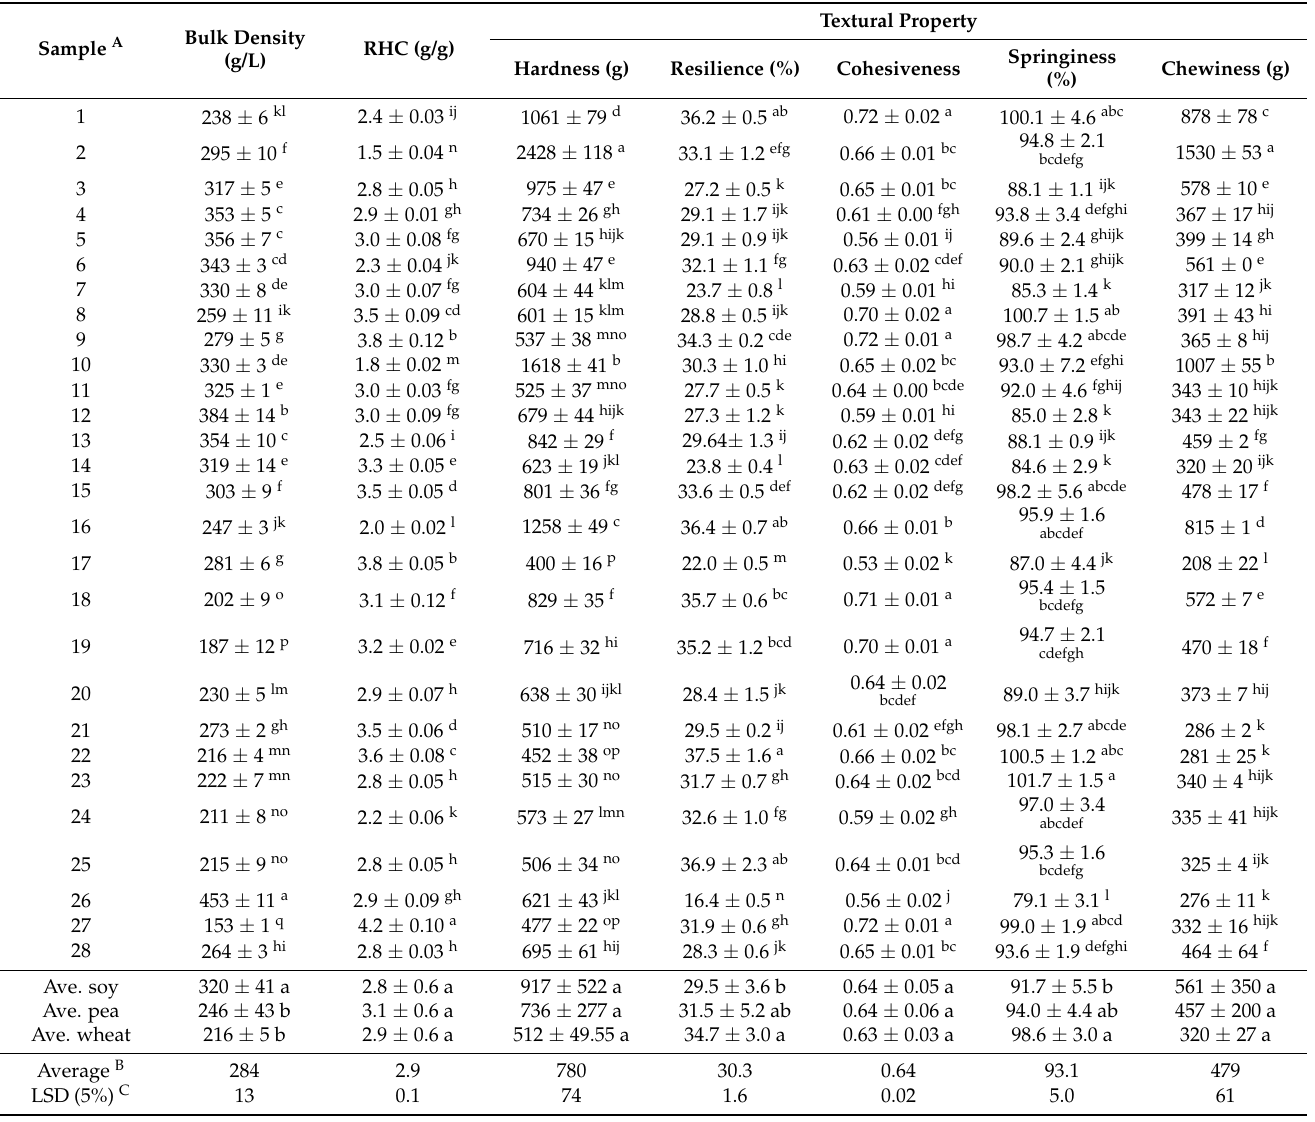
Table 4. Rehydration and textural properties of